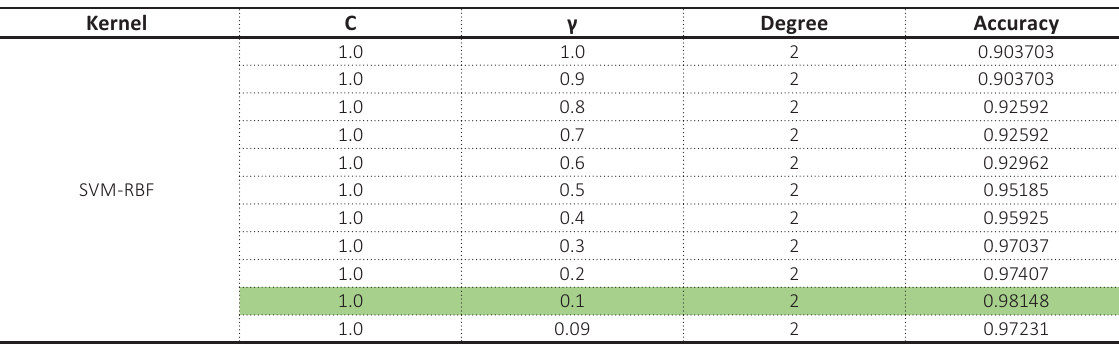
Table A6. Test of the SVM-Poly parameters by the function Gird-Search Kernel